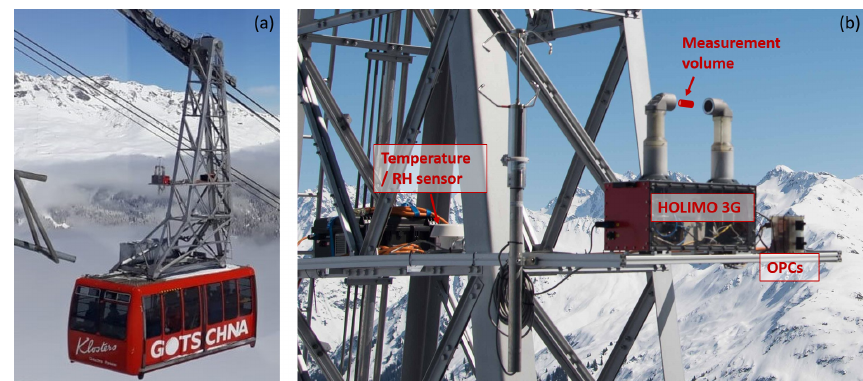
Figure 2. The HoloGondel platform installed on the Gotschnabahn in (a) and an enlarged picture of the platform in (b) , showing HOLIMO 3G with its measurement volume between the two towers, two optical particle counters (not used in this study) next to HOLIMO, and the temperature and relative-humidity (RH) sensor. The sonic anemometer was turned off due to a limited supply of